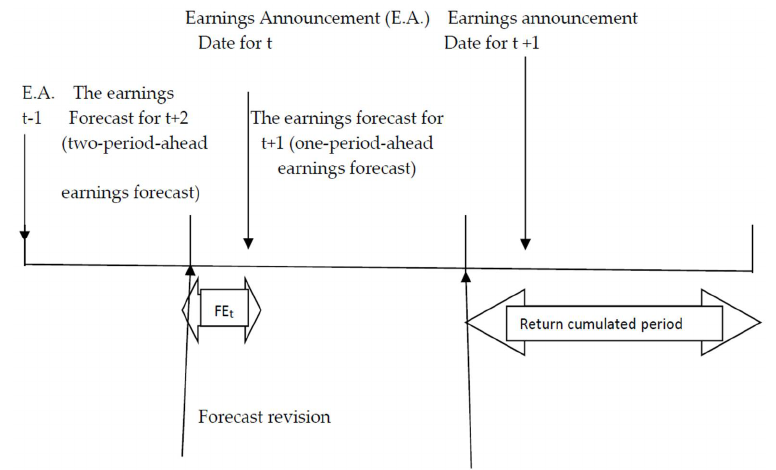
Figure 1. The timeline related to the analyses in the paper.